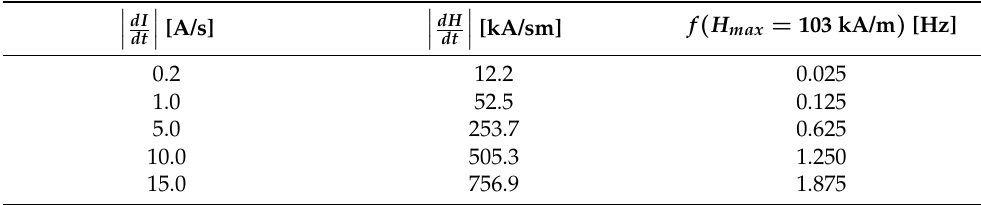
Table 1. Slew rates and frequencies of the magnetic field for cases shown in Figure 3a, where the maximal field amplitude was H max ≈ 103